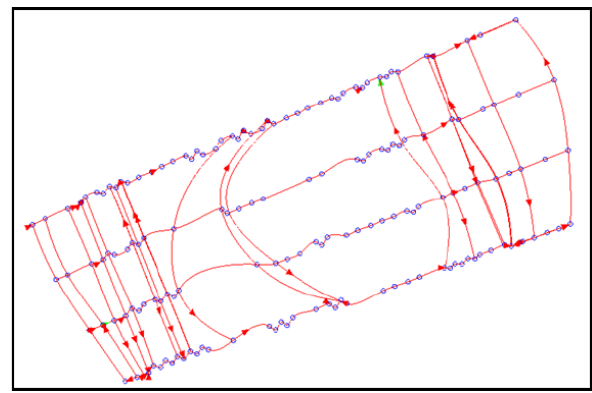
Figure 6: The result of fitting curves 2.2.3 Surface fitting: Figure 7 shows the process of fitting surface based on 8 green curves in this group, this surface through all of the curves and points in this group. A series of fitting surface can be generated by this method.